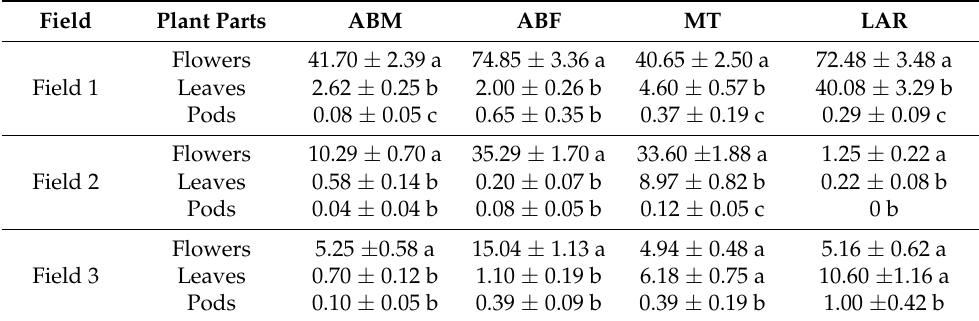
Table 2. Mean ± SE number of Asian bean thrips and melon thrips collected from three different fields in different plant parts.